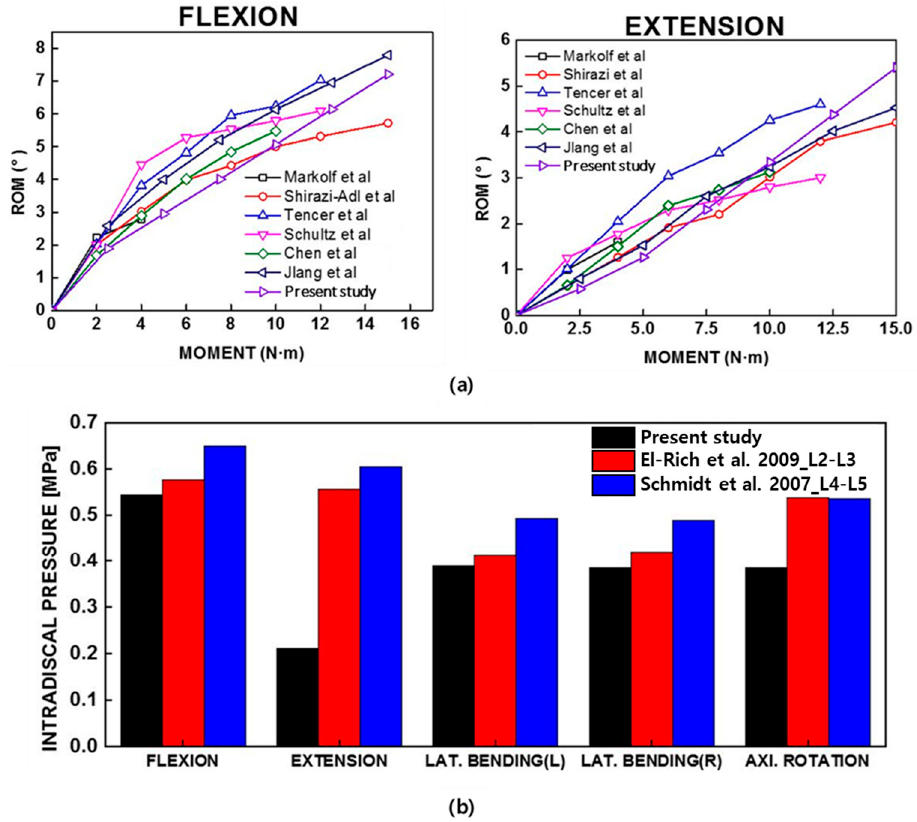
Figure 4. Comparison ( a ) range of motions (RoMs) ( b ) intradiscal pressure (IDP).